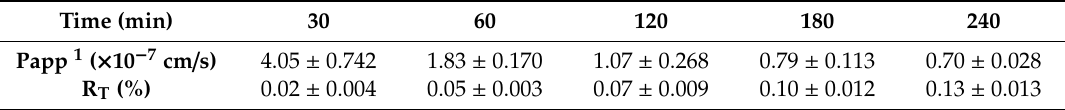
Figure 2. Validation of a fast seven day Caco-2 cell monolayer model. ( a ) Real-time monitoring of changes in TEER values; ( b ) alkaline phosphatase activity assay (AP/BL). Table 5. Papp values and R T (%) of sodium fluorescein at different times.